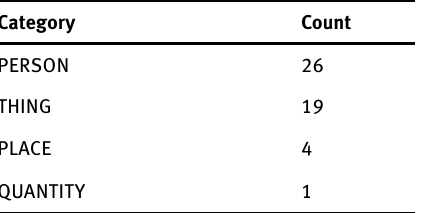
Table 5: Frequencies of restricted repair initiators using ‘WH’ words, by ontological category